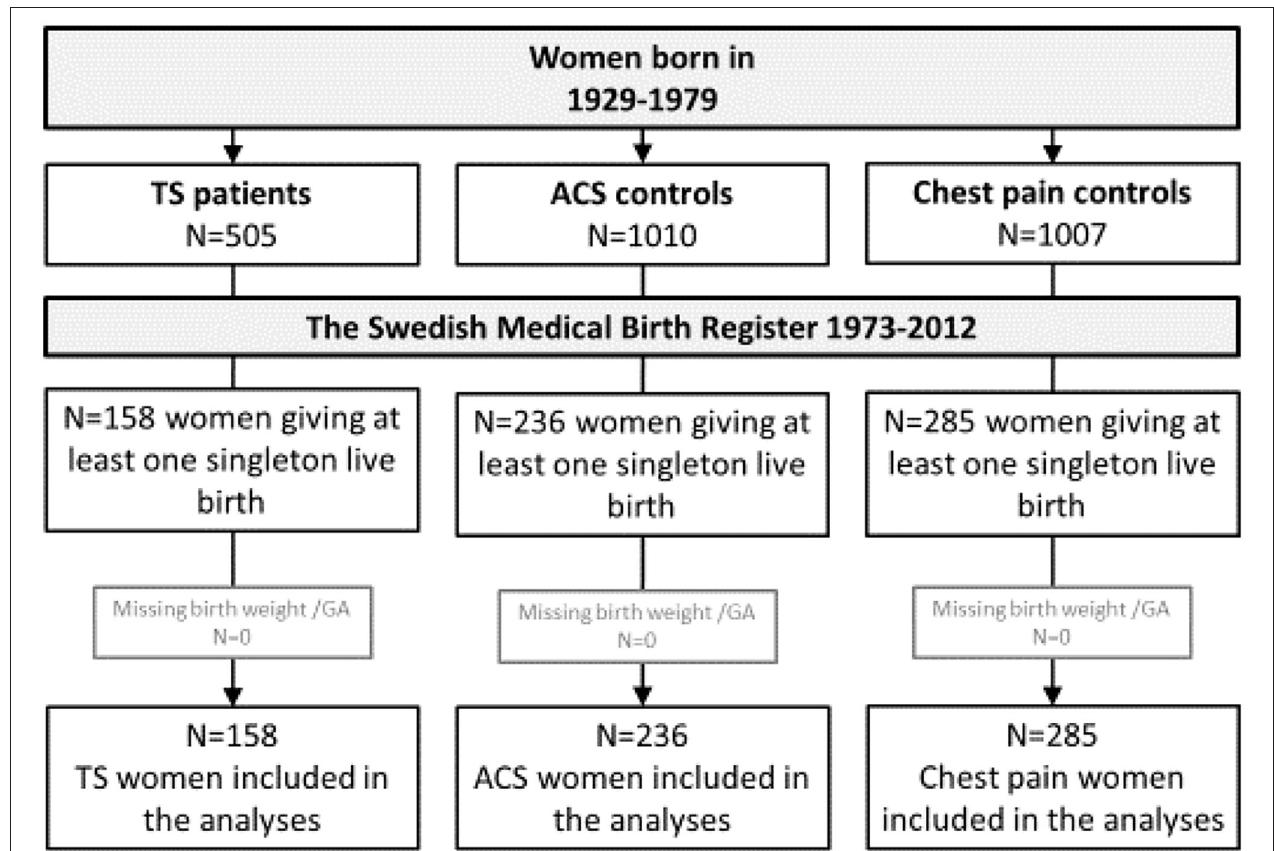
FIGURE 1 | Flow chart of women identified in the Swedish coronary angiography and angioplasty register with data from the Swedish medical birth register. ACS, acute coronary syndrome; TS, takotsubo